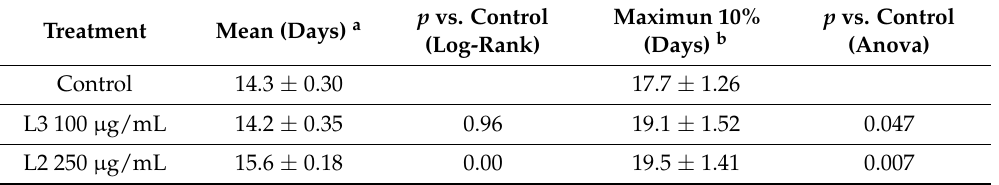
Table 4. Influence of L3 extract 100 µ g/mL and L2 extract 250 µ g/mL in the culture medium on the lifespan of wild-type N2 C. elegans under normal grown conditions at 20 ◦